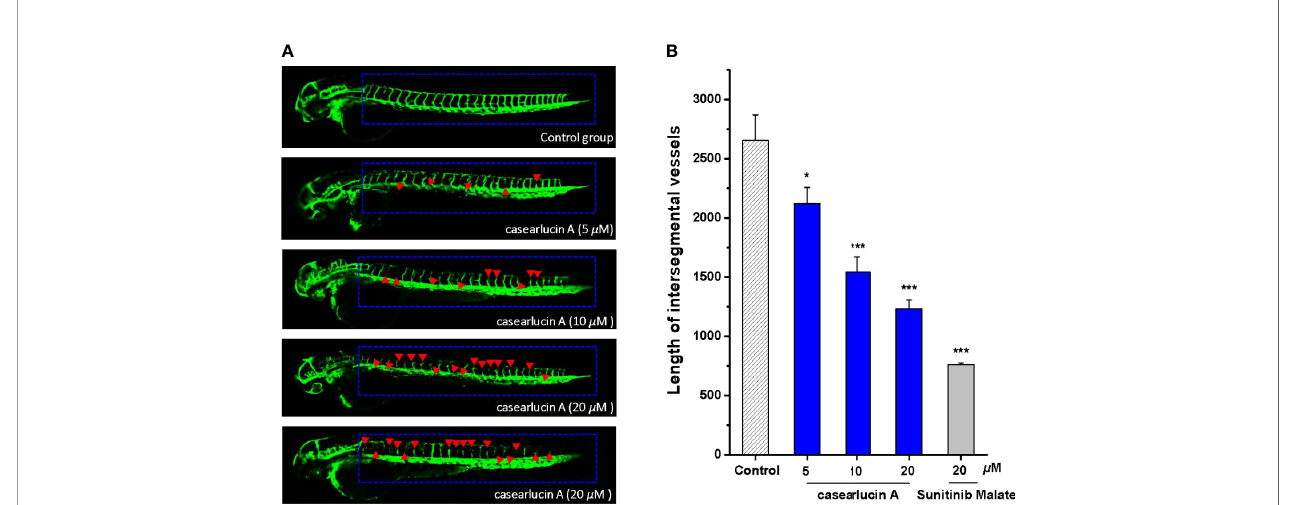
FIGURE 8 | Anti-angiogenesis activity of casearlucin A in transgenic zebra fi sh model. The embryos from transgenic zebra fi sh Tg ( fl i1: EGFP) were treated by the tested compound and the anti-angiogenetic compound, sunitinib malate (positive control). DMSO was used as a negative control. After exposure to the compounds for 48 h, the development of intersegmental vessels (ISVs) and dorsal longitudinal anastomotic vessels (DLAVs) were observed, and the length of ISV vessels was measured using ImageJ program. (A) Representative images of zebra fi sh embryos treated with vehicle, casearlucin A, and sunitinib malate. (B) The average length of ISVs of zebra fi sh after treated with different concentrations of casearlucin A (5, 10, and 20 m M). (n = 15 for each experimental group). * p < 0.5, *** p < 0.001 versus control group.